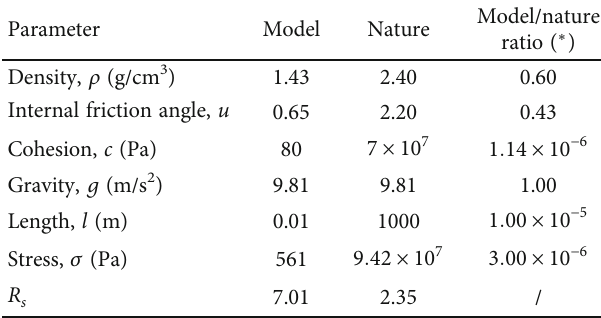
Table 3: Scaling of models and geologic entity.